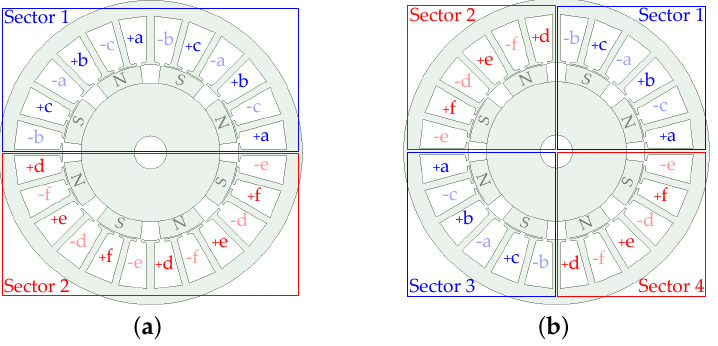
Figure 4. Types of multisector WSAs for a six-phase machine with eight pole pairs. ( a ) Two pole pairs per sector. ( b ) One pole pair per